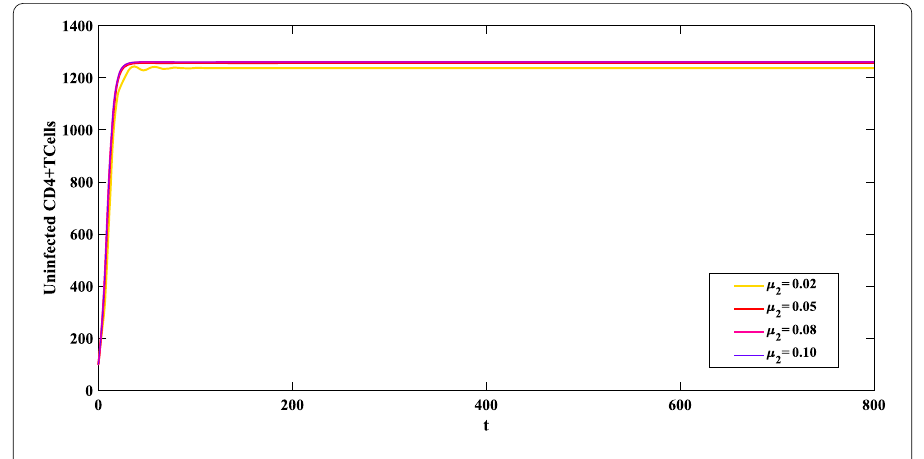
Figure 4 The phase diagram shows an increased number of non-infected CD4 + T-cells, while the antibody neutralization response is